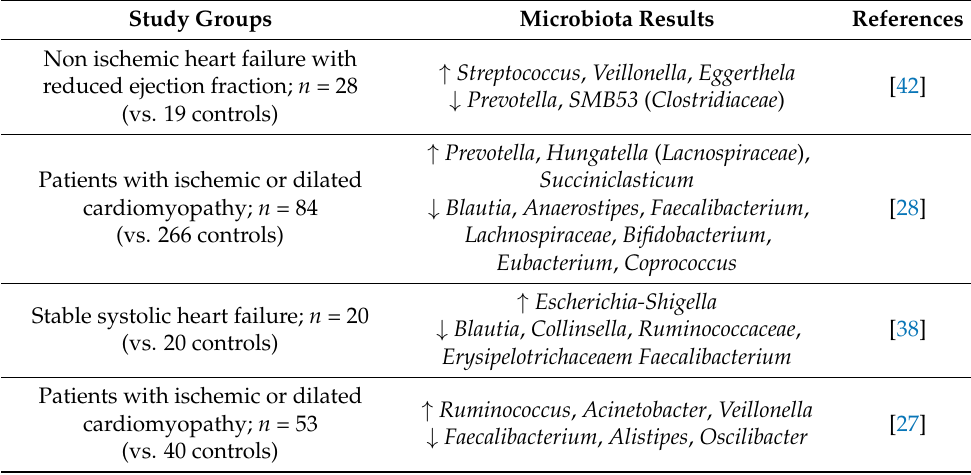
Table 1. Studies concerning gut dysbiosis in CVD